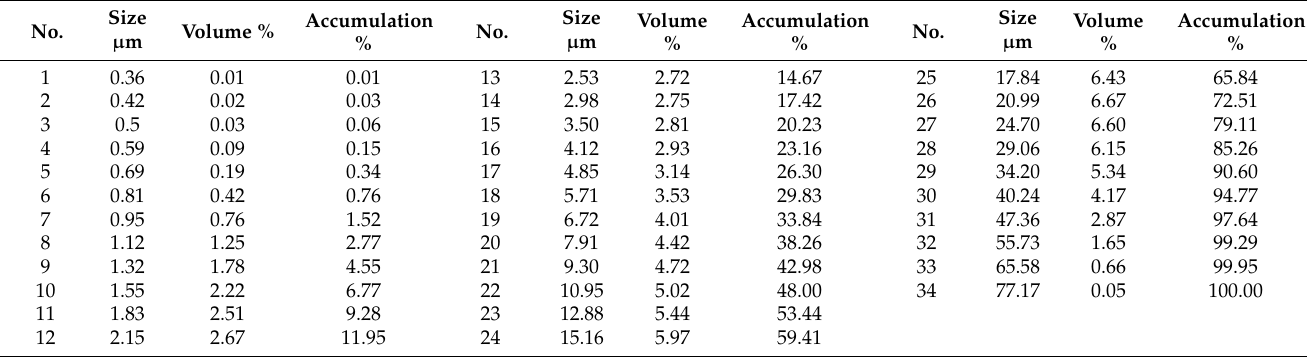
Table 1. Particle size, volume proportion, and cumulative